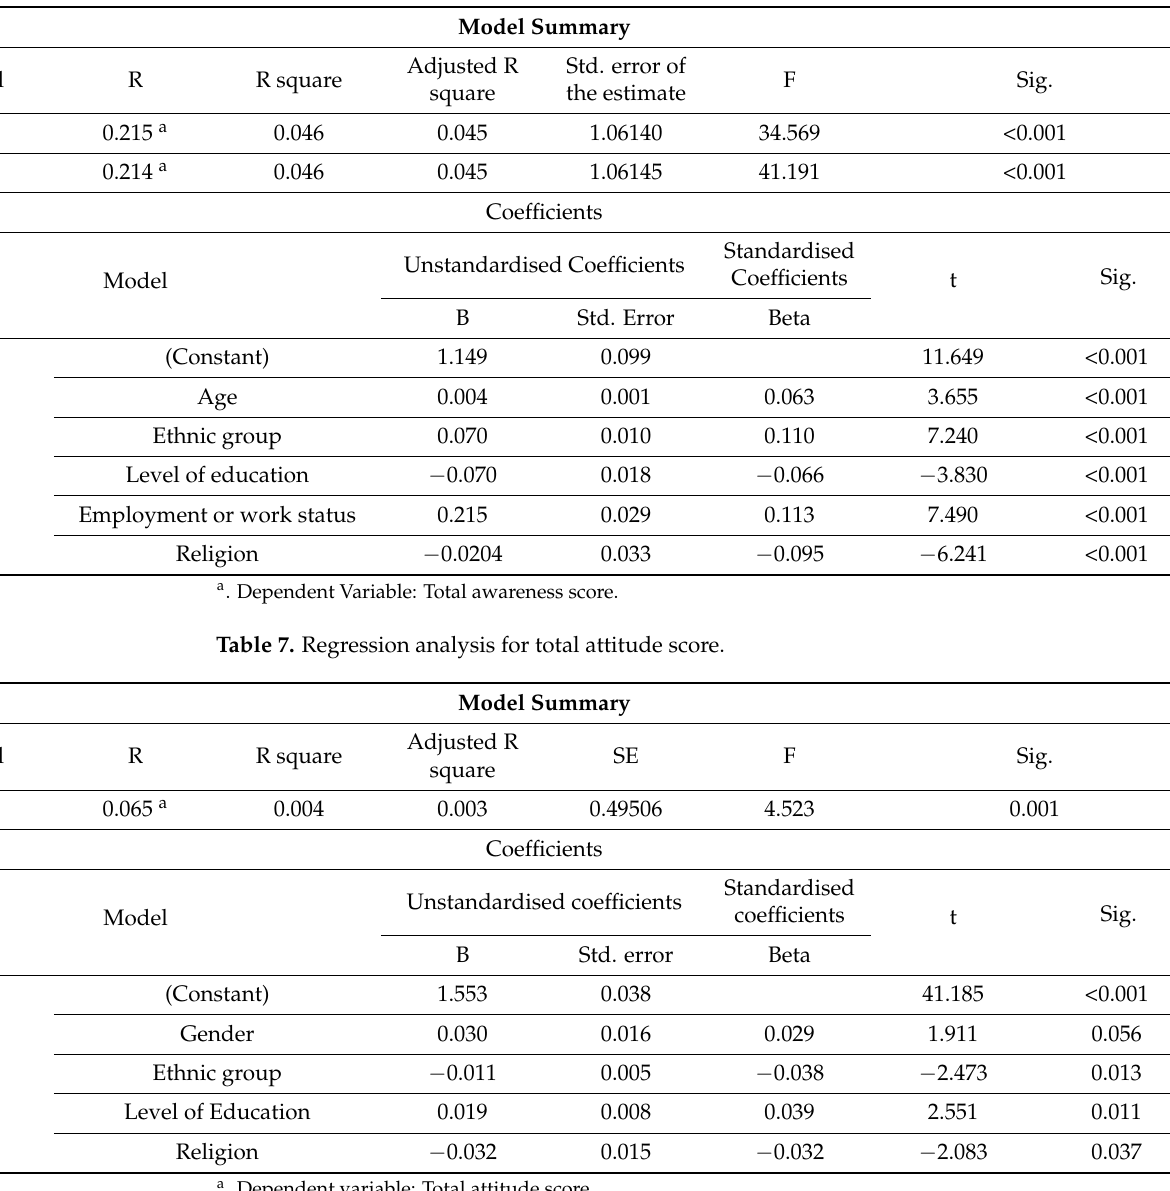
Table 6. Regression analysis for total awareness score.